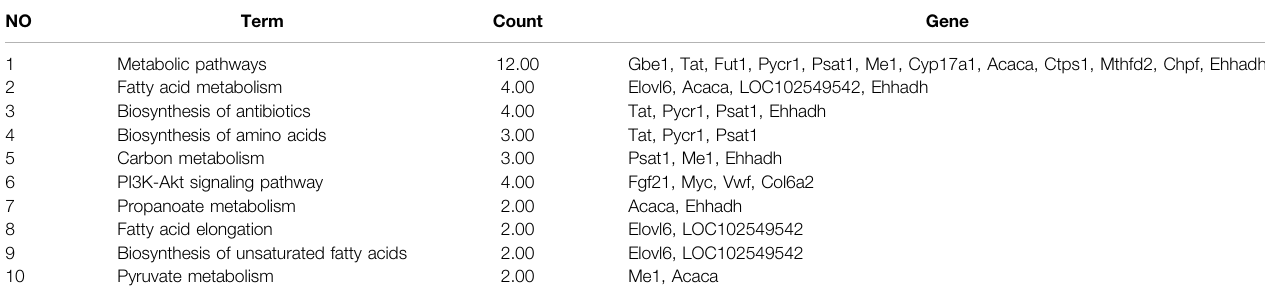
TABLE 2 | KEGG pathway enrichment analysis of co-regulatory genes (by Davide, Dec. 20th,